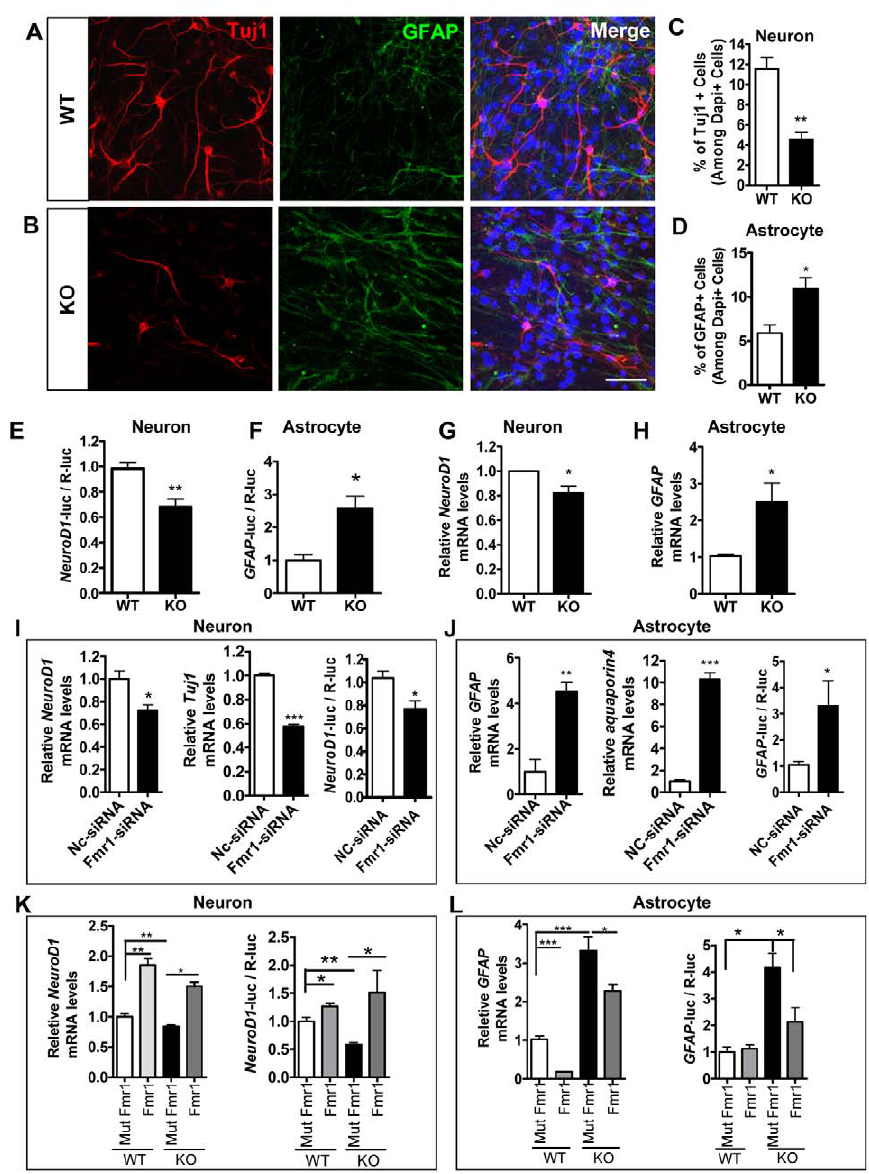
Figure 2. Loss of Fmrp leads to decreased neuronal differentiation but increased astrocyte differentiation. (A,B) Sample immunostained cells using cell lineage markers for quantitative cell fate determination shown in (C,D). Both WT (A) and Fmr1 KO (B) aNPCs could differentiate into Tuj1 + (red) neurons and GFAP + (green) astrocytes. (Scale bar=50 m m; DAPI, nuclear staining, blue). (C,D) Quantitative analyses of differentiated aNPCs demonstrate that Fmr1 KO aNPCs differentiated into fewer Tuj1 + neurons (C, n=4; p , 0.01) but more GFAP + astrocytes (D, n=6, p , 0.05). Quantification was performed using an unbiased stereology method. (E,F), Luciferase reporter assay showing that differentiating Fmr1 KO aNPCs had decreased NeuroD1 (E; n=4, p , 0.01), but increased GFAP (F, n=3, p , 0.05) promoter activities compared with WT aNPCs. A co- transfected Renilla luciferase (R-Luc) plasmid was used as a transfection control. (G,H), Real-time PCR assays showing that Fmr1 KO aNPCs had decreased NeuroD1 mRNA levels (G; n=3, p , 0.05), but increased GFAP mRNA levels (H, n=3, p , 0.05) upon differentiation. The relative mRNA levels were in comparison with GAPDH mRNA. (I,J), Acute knockdown of Fmrp expression in WT aNPCs using siRNA led to decreased neuronal differentiation (I; left NeuroD1 ; middle, Tuj1 ; right, NeuroD1 -promoter), but increased astrocyte differentiation (J; left GFAP ; middle, aquaporin4 ; right, GFAP -promoter); (K,L), Exogenously expressed WT Fmrp, but not mutant (I304N) Fmrp, could enhance neuronal differentiation (K) and repress astrocyte differentiation (L) in Fmr1 KO aNPCs. GAPDH mRNA levels were used as internal controls for real-time PCR analyses. Data are presented as mean 6 SEM; *, p , 0.05, **, p , 0.01, ***, p , 0.01, Student’s t-test. were also reduced in the hippocampus of Fmr1 KO mice neurons was 10.4% lower (Figure 3F, p , 0.05), whereas the (Figure S5, n = 3, p , 0.05). Therefore, the loss of Fmrp leads to percentage of BrdU-positive cells that are S100 b + astrocytes was 75.7% higher compared with WT mice (Figure 4G, reduced neuronal differentiation but greater glial differentia- p , 0.05). In addition, the expression levels of NeuroD1 and tion in aNPCs residing in the DG. These in vivo data along with Neurog1, two transcription factors expressed in new neurons, our in vitro results suggest that Fmrp indeed plays important